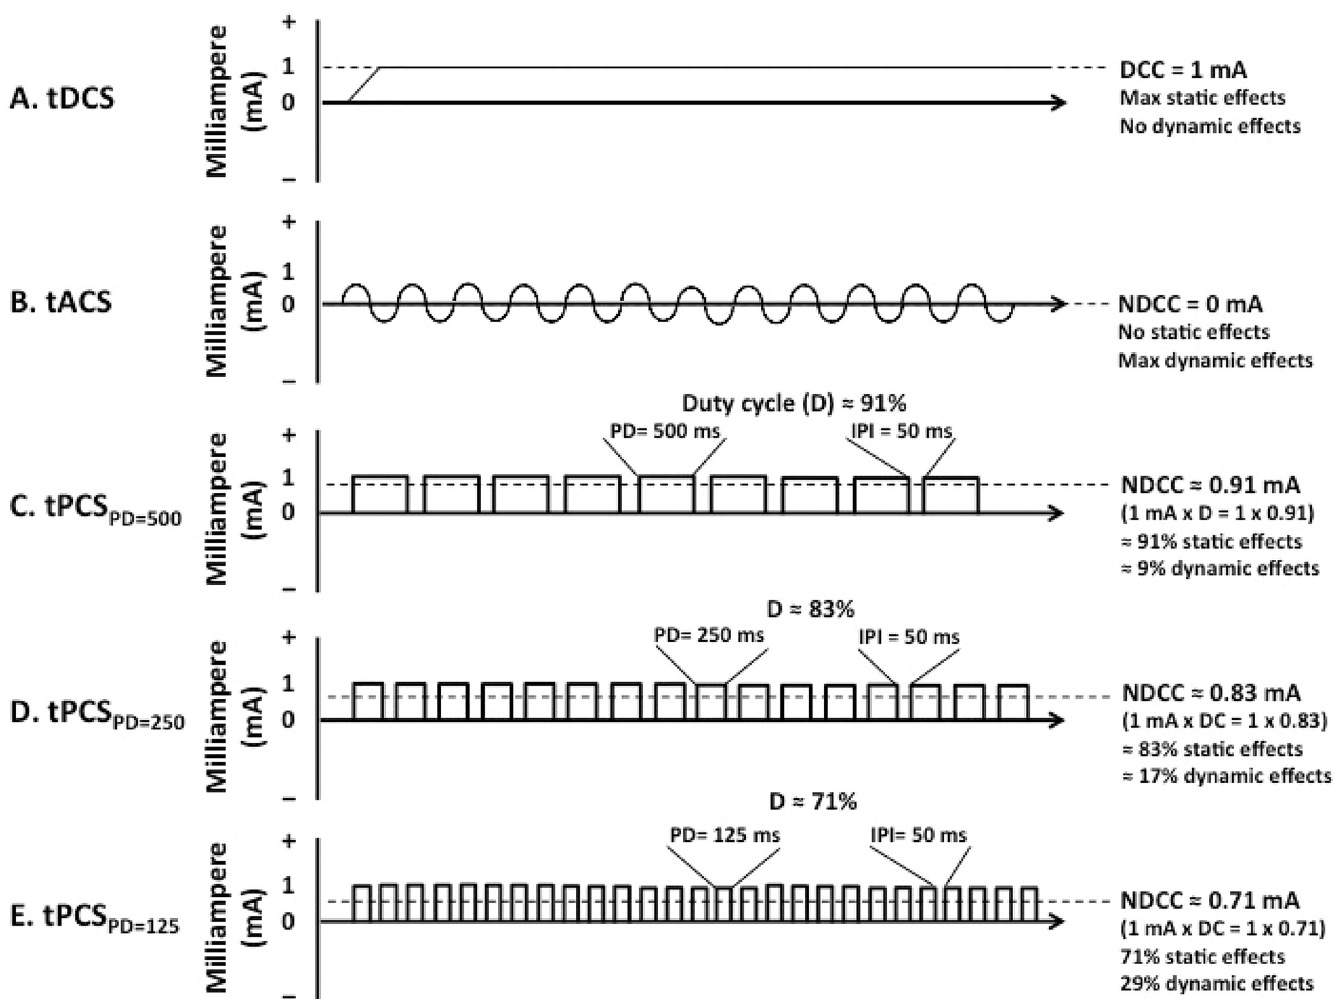
Fig 1. Direct, alternative and pulsatile currents. (a) tDCS; transcranial direct current stimulation, (b) tACS: transcranial alternating current stimulation, (c) tPCS PD = 125 : transcranial pulsed current stimulation with 125 ms pulse duration, (d) tPCS PD = 250 : transcranial pulsed current stimulation with 250 ms pulse duration, and (e) tPCS PD = 500 : transcranial pulsed current stimulation with 500 ms pulse duration. DCC: direct current component; NDCC: net direct current component, PD: Pulse duration, IPI: Inter pulse interval, D: Duty cycle